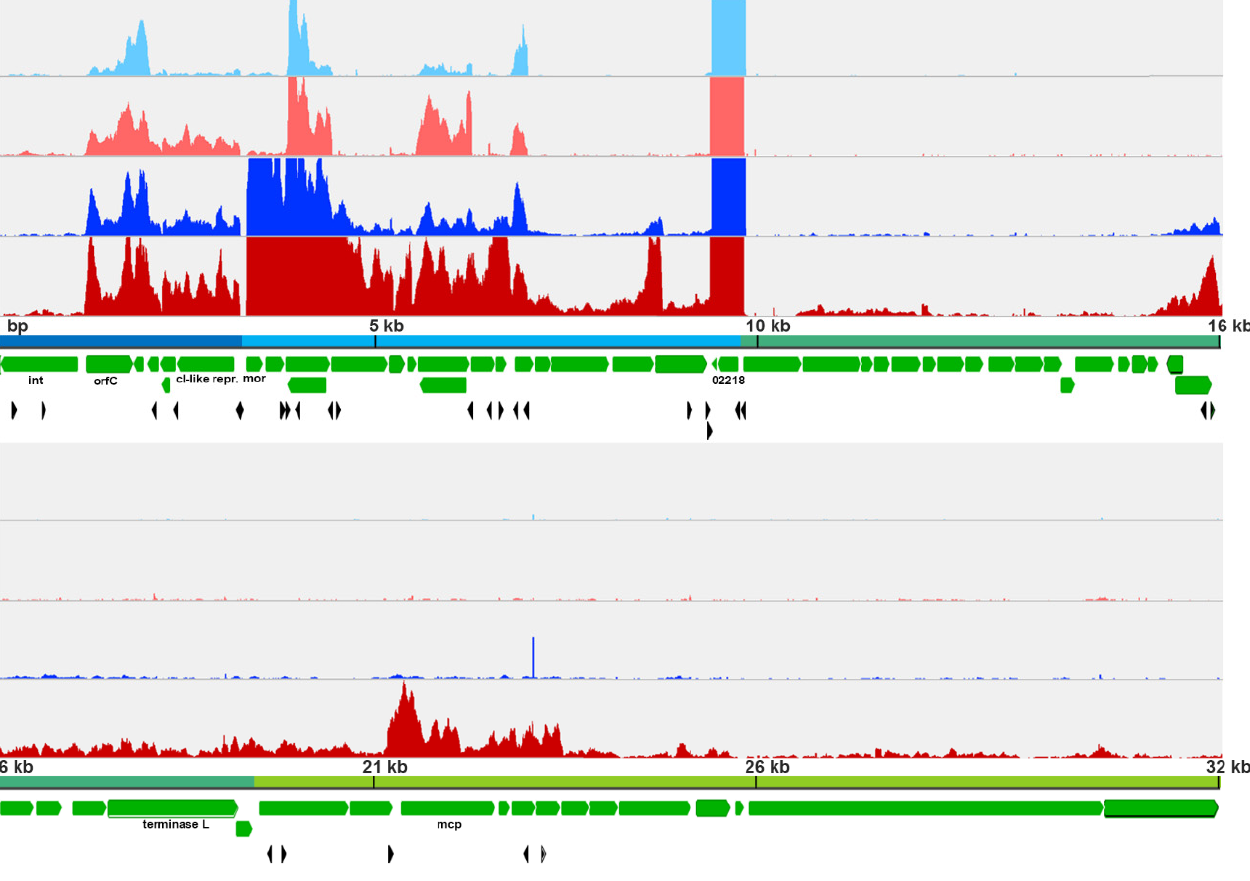
Figure 4. Visualization of predicted and enriched TSS and transcriptional profile of extracted Ф 13 prophage region. Reads mapping to the phage genome are visualized for MW2c- and 8325-4 Φ 13kan- ∆ rep strains under uninduced (light red and light blue, respectively) and induced (1 h mitomycin C treatment; dark red and dark blue) conditions from a representative sample out of 3 replicates. The maximum for the Y-axis in each panel is 200 counts. Protein coding genes are depicted in green and predicted TSS (Table S3) by black arrowheads.